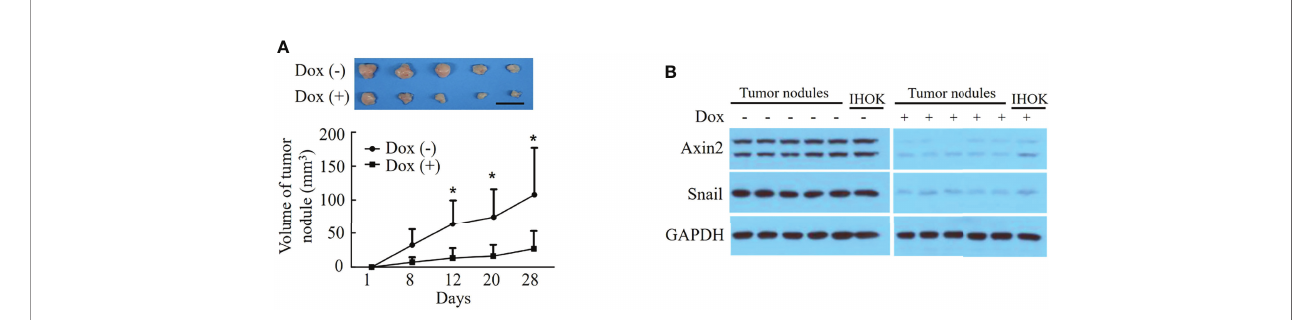
FIGURE 4 | Knockdown of Axin2 attenuates tumorigenic activity in the IHOK line. (A) The volume of the tumor nodules was signi fi cantly lower in the doxycycline- treated group than in the control group (* P =0.032, Scale bar: 1cm). (B) Western blot analysis revealed decreased Axin2 and Snail expression both in the pLKO-Tet- shAxin2 vector-transfected IHOK line and tumor nodules from groups treated with doxycycline compared with that